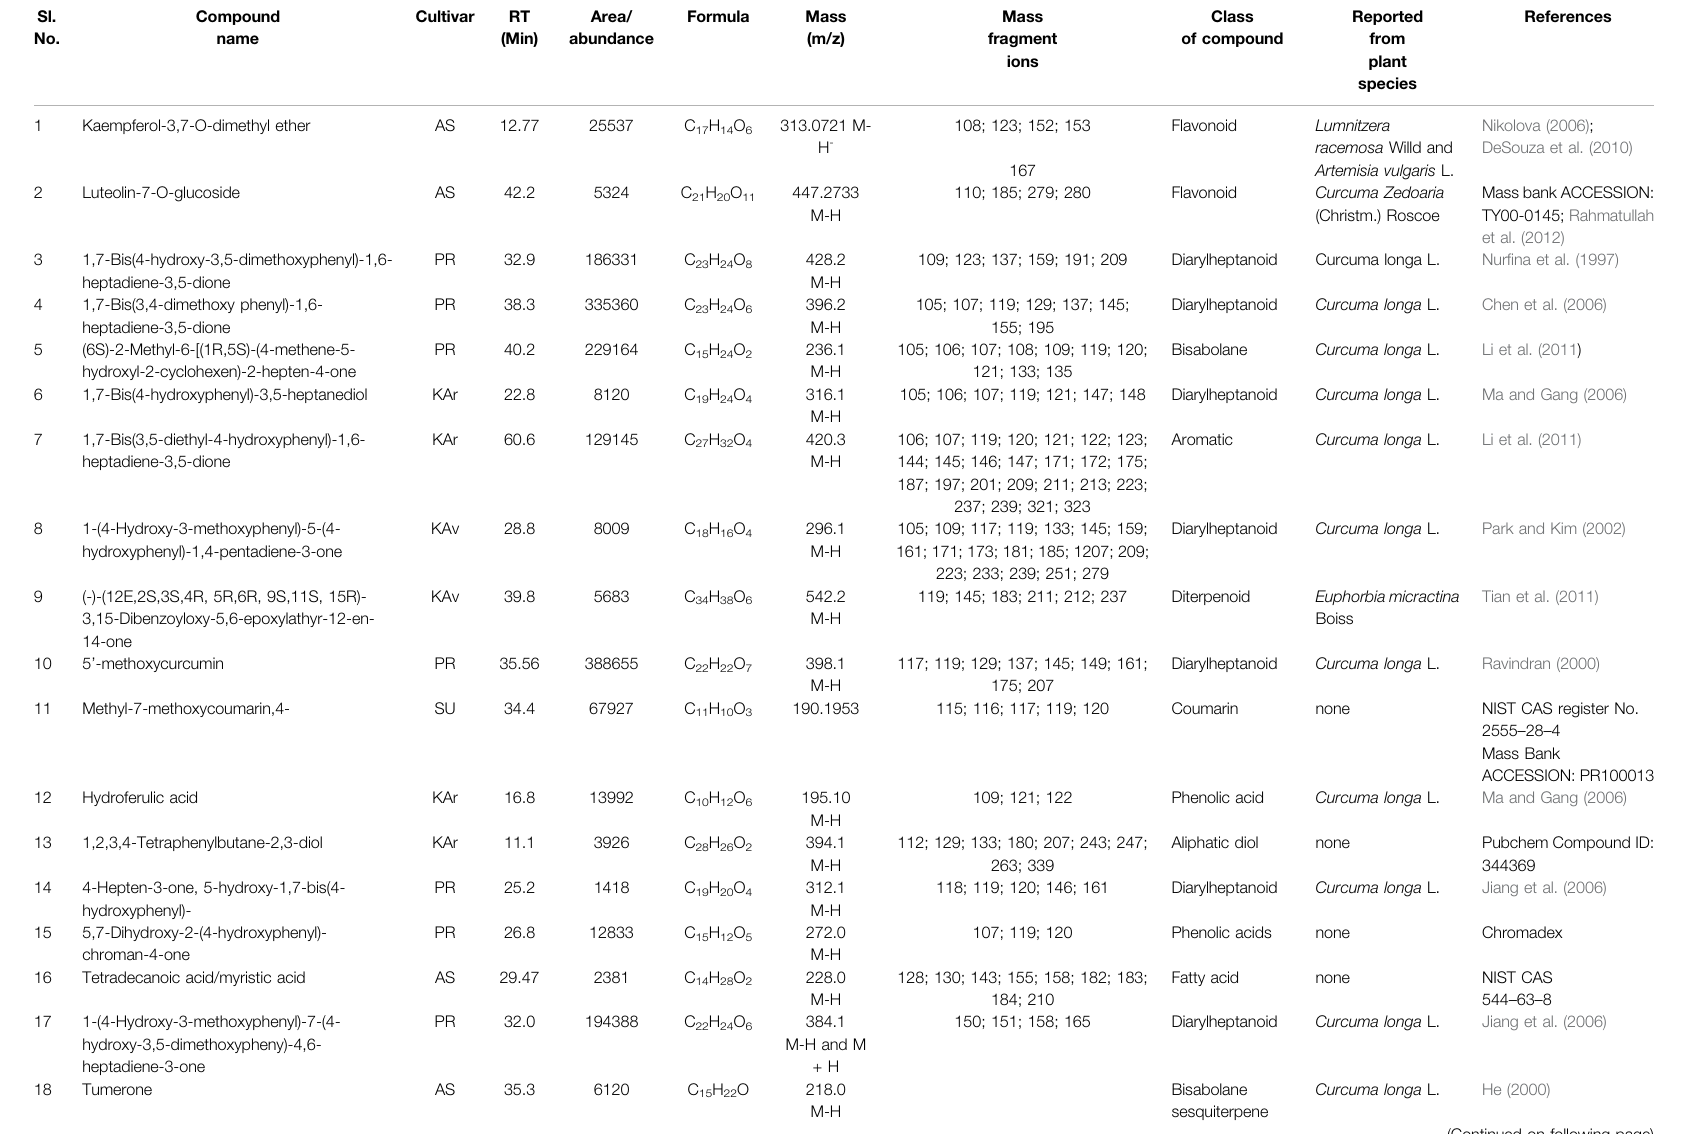
TABLE 6| Cultivar-speci fi c compounds identi fi ed by LC-MS in the rhizome extracts from one ofthe seven cultivars of Curcuma longa L. and C. aromatica Salisb. The structure of the compound with the serial number “ 1 ” is given in Figure 2 (panel number: 36) and compounds with Sl. Nos. 2, 3 – 9 are given in Figure 4 with the corresponding panel nos. 3, 5 – 11, respectively. Abbreviations used: AS, Alleppey Supreme; DR, Duggirala Red; PR, Prathibha; SA, Salem; SU, Suguna; KAr, Kasturi Araku; KAv, Kasturi Avidi. Sl.